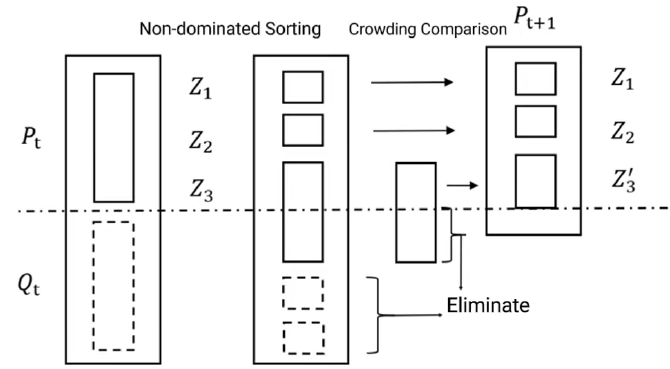
Figure 4. Elite strategy diagram .